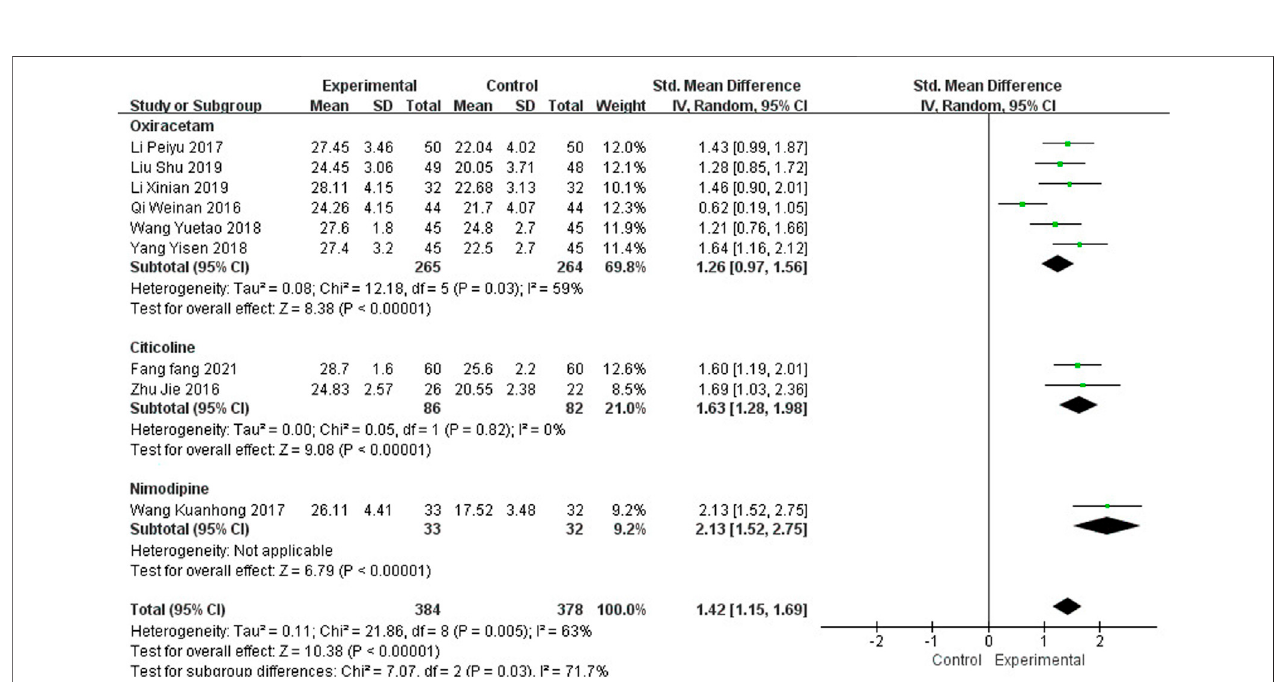
FIGURE 5 | Meta-analysis of MMSE by NBP as monotherapy.